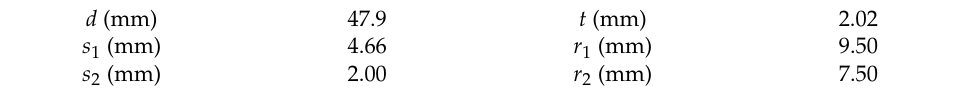
Figure 2. Diagram of the dimensions of the analyzed transducers, ( a ) in the shape of circular segment, ( b ) in the shape of an intersection of circles. Table 1. Dimensions of the